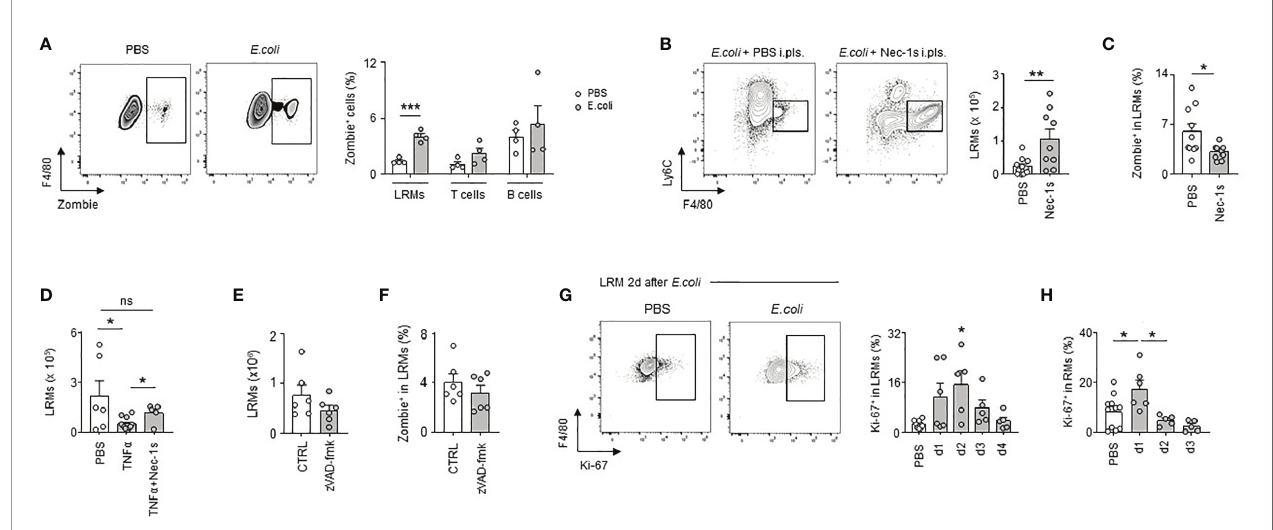
FIGURE 4 | E. coli -induced pleural large resident macrophage necroptosis is followed by local macrophage proliferation. (A) Representative dot plots for LRMs and percentage of death of LRMs, T cells and B cells in their respective population 24h after i.t. infection of 5x10 6 CFU of E. coli (n=4). (B) Representative dot plots and enumeration of LRM in pleural space 24h after i.t. infection of 5x10 6 CFU of E. coli and i.pls. injection of 100µg of necrostatin-1s (Nec-1s) or PBS (PBS) (n=9 mice). (C) Percentage of death of LRMs in the LRM population 24h after i.t. infection of 5x10 6 CFU of E. coli and i.pls. injection of 100µg of necrostatin-1s (Nec-1s) or PBS (PBS) (n=11 mice). (D) Enumeration of LRM in pleural space 24h after i.pls. injection of 100ng of recombinant TNF a with and without i.pls. injection of 100µg of necrostatin-1s (n=6-12 mice). (E) Enumeration of LRMs in pleural space 24h after i.t. infection of 5x10 6 CFU of E. coli and i.pls. injection of 100µg of zVAD-fmk or control (CTRL) (n=6 mice). (F) Percentage of death of LRMs in the LRM population 24h after i.t. infection of 5x10 6 CFU of E. coli and i.pls. injection of 100µg of zVAD-fmk or control (CTRL) (n=6 mice). (G) Representative dot plots and percentage of pleural Ki-67 + LRM in the LRM population during steady-state and 1, 2, 3 and 4 after i.t. infection of 5x10 6 CFU of E. coli (n=5-7 mice per time point). (H) Percentage of Ki-67 + LRM in the LRM population during steady-state and 1, 2 and 3 days after i.n. injection of LPS (n=5-11). Data are pooled data from at least 2 independent experiments. Data represent mean ± S.E.M. and were analyzed by the two-tailed unpaired t-test or by the Dunnett ’ s multiple comparisons test. *p<0.05; **p<0.01;